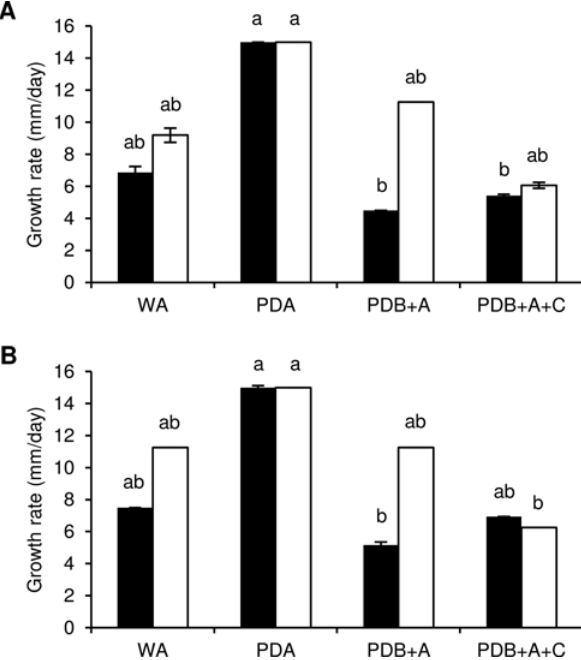
Figure 1. Mean mycelium growth rates of the Diplodia seriata strain S (black) and D. seriata strain VT (white), grown a) in com- plete darkness and b) with a 16:8 hour light:dark photoperiod on water agar (WA), potato dextrose agar (PDA), potato dextrose broth supplemented with agar (PDB+A) and PDB+A supplement- ed with cellulose (PDB+A+C) for 28 d at 27°C. The Kruskal-Wallis test showed no significant differences between the two experimen- tal repetitions ( P > 0.05, n = 4 replicates per experiment) and data from the two experiments were pooled. Means and standard errors of eight replicates (dishes) from the two experiments are shown for each fungal strain and growth medium. Different letters indicate significant differences (Kruskal-Wallis test; P